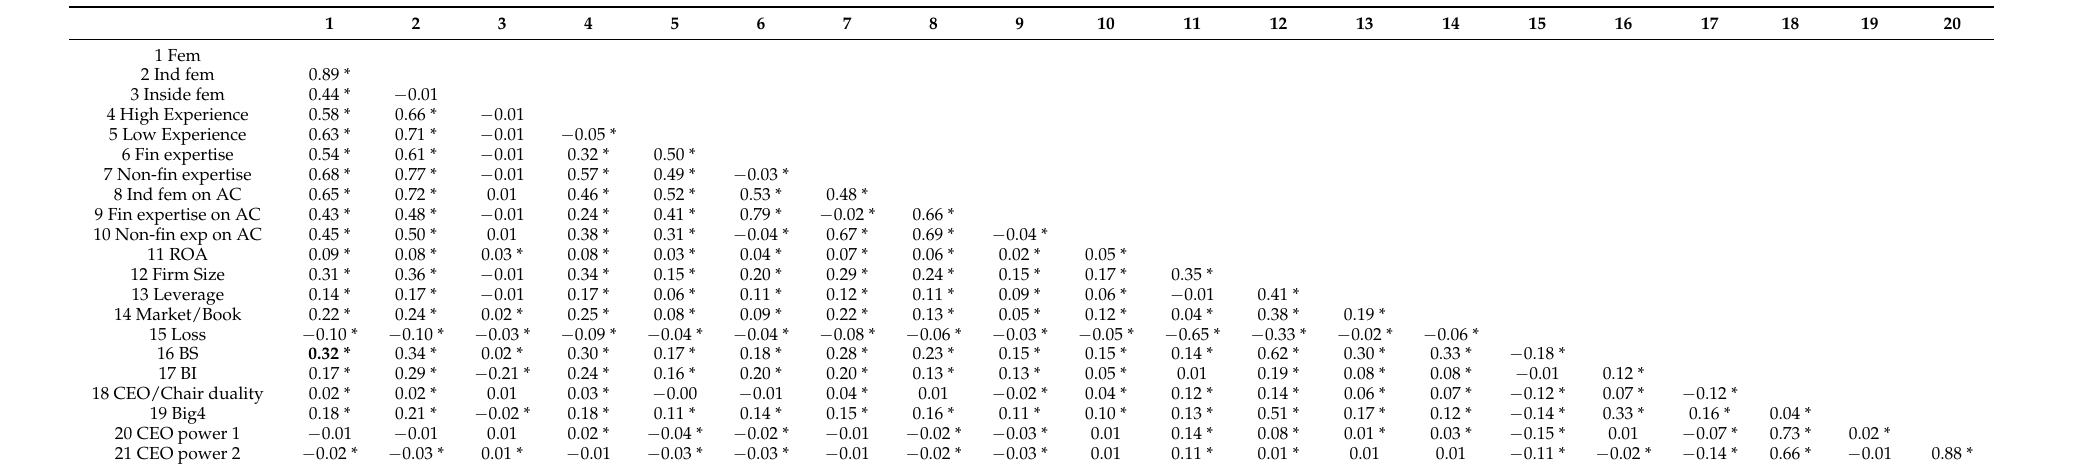
Table 4. Correlation